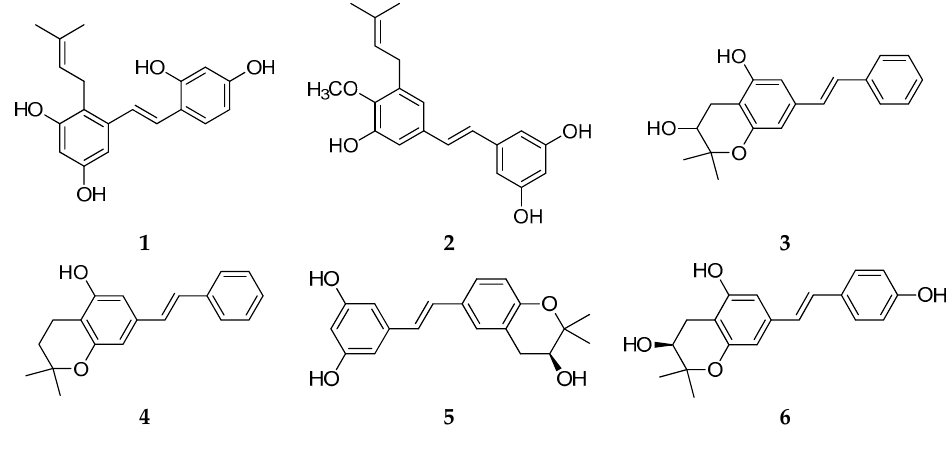
Figure 2. The structure of resveratrol monomers.